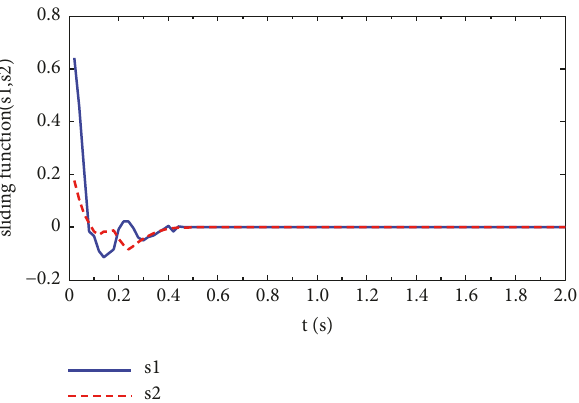
Figure 6: System state trajectory with classic reaching law based SMC.